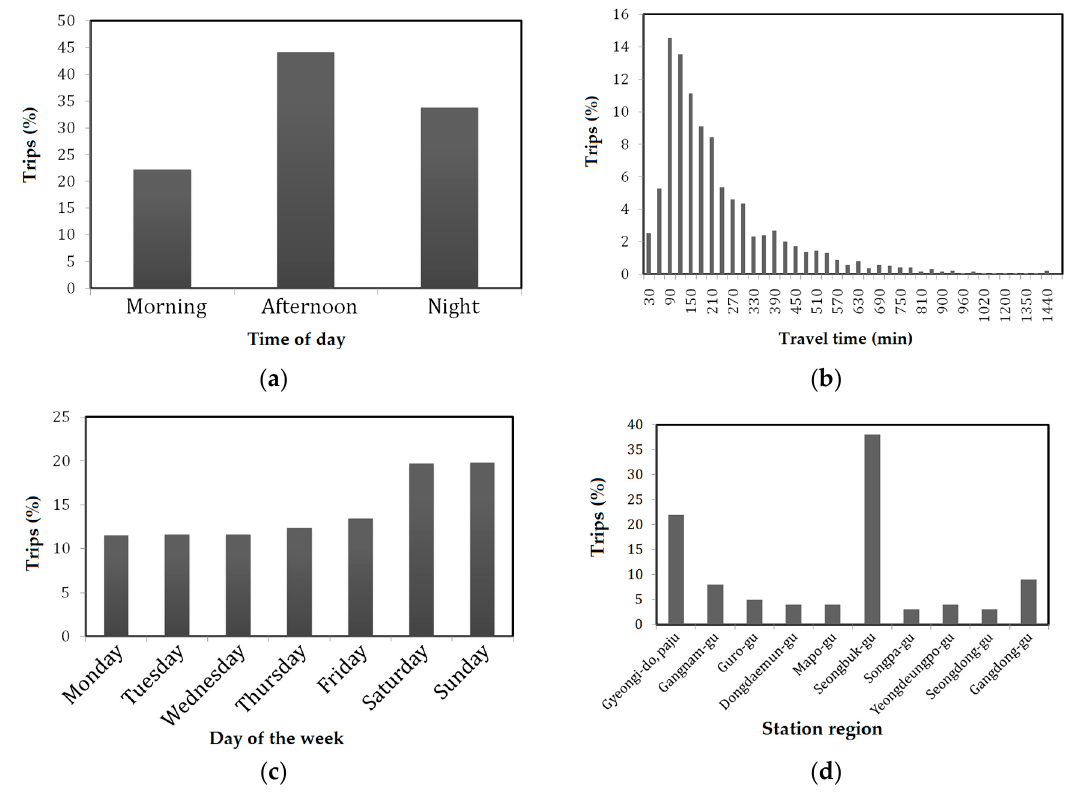
Figure 3. Dataset distributions: ( a ) time of the day; ( b ) vehicle hour trips (VHT); ( c ) day of the week; and ( d ) customer departure.